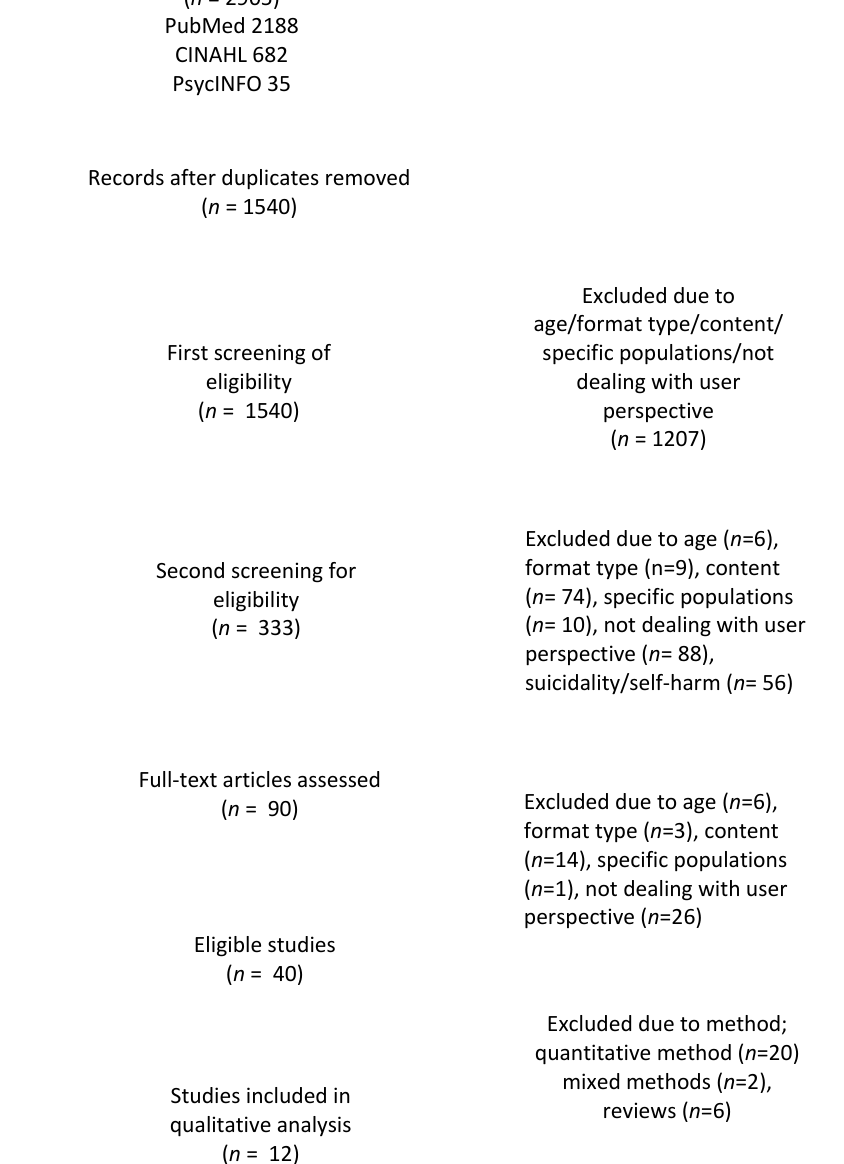
Figure 1. Article search and selection process — PRISMA diagram.